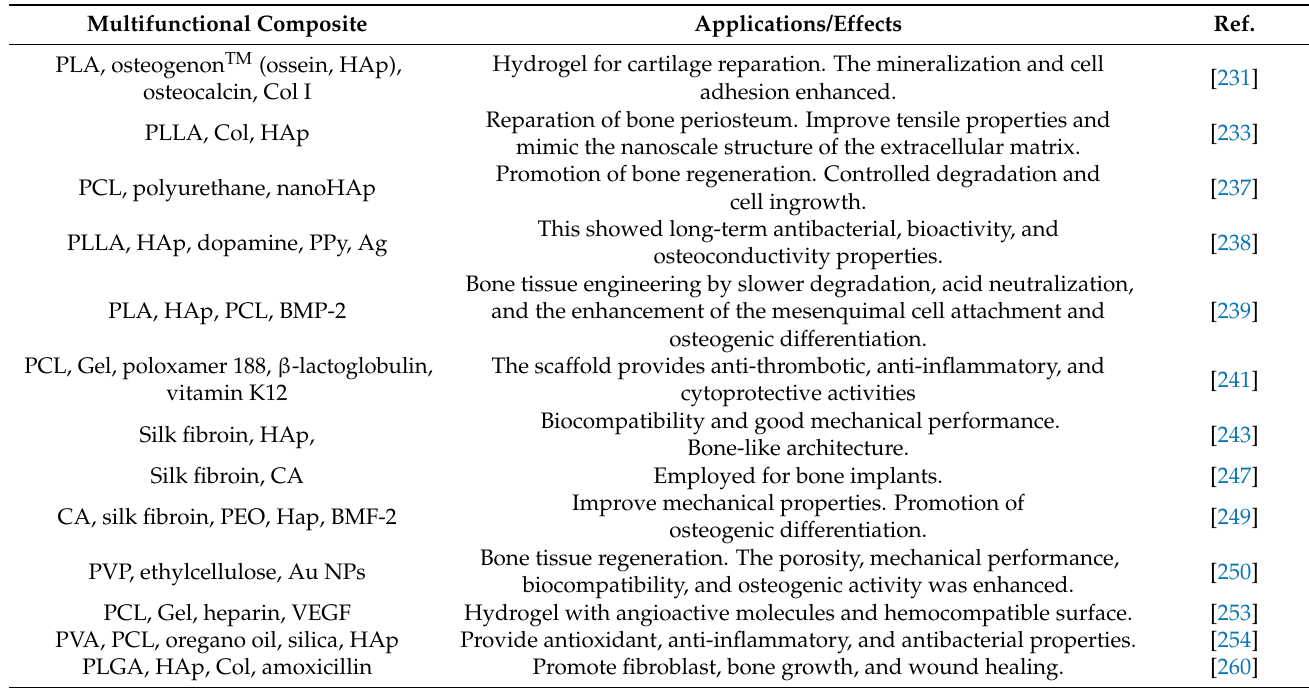
Table 1. Multifunctional electrospun